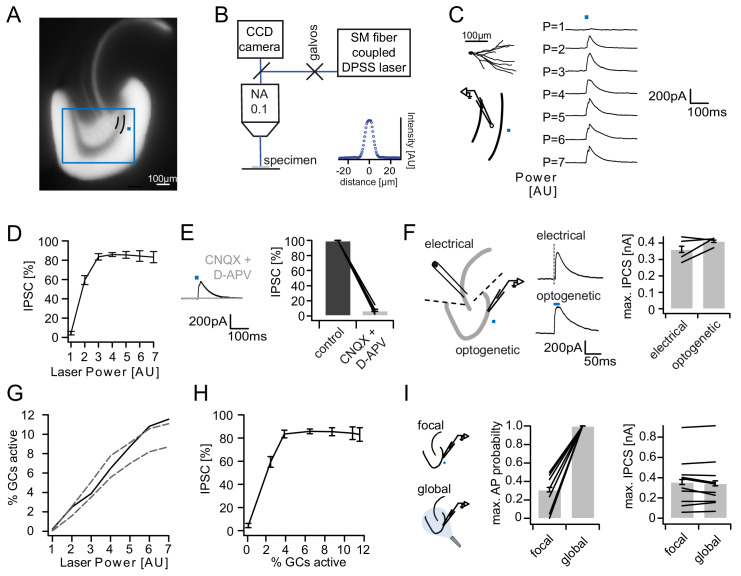
Recruitment of feedback inhibition assessed optogenetically.(A) EYFP fluorescence in dentate GCs of Prox1/ChR2(H134R)-EYFP transgenic mice. The field of view for rapid focal optogenetic stimulation is indicated by a blue square. A typical stimulation site approx. 40 µm from the GC layer (two short black lines) is indicated by a blue dot. (B) Schematic of the microscope setup used to achieve spatially controlled illumination. The inset shows the intensity profile of the laser spot. (C) Top left, reconstruction of an Alexa594 filled GC. Left, illustration of optical stimulation. Right, IPSCs following 20 ms light pulses at increasing laser power (p=1 to 7 AU). Each trace represents an average of three trials. (D) Summary of IPSC amplitudes from cells in the superior blade (n = 7 cells). IPSC amplitudes were normalized to the maximum amplitude within each cell. (E) Optogenetically elicited IPSCs are abolished by glutamatergic blockers (40 µM CNQX + 50 µM D-APV, n = 9). (F) Left, Schematic of focal optical and electrical stimulation. Dashed lines indicate cuts to sever CA3 backprojections. Middle, Example traces for IPSCs following electrical or focal optogenetic stimulation. Right, maximal IPSC amplitude for the two stimulation paradigms (361 ± 37 vs. 410 ± 13 pA for electrical and optogenetic stimulation respectively, paired t-test, p=0.28, n = 4) (G) The optogenetically activated GC fraction responsible for recruiting the IPSC at the respective laser powers was estimated from systematic cell attached recordings (see Figure 2—figure supplement 1 for details). The best estimate (black) incorporates measurements of the 3D light intensity profile in the acute slice. Upper and lower bounds were estimated by assuming no firing probability decay with increasing slice depth (upper grey dashed line) or isometric firing probability decay (lower grey dashed line. (H) Data from (D) and (H, best estimate) plotted to show the recruitment of feedback inhibition. (I) Comparison of focal optogenetic stimulation to global (light fiber mediated) optogenetic stimulation. Left, Schematic illustration. Middle, Comparison of the AP probability of individual GCs at maximal stimulation power for focal and global stimulation assessed by cell attached recordings. Right, Comparison of the maximal IPSC amplitude under focal and global stimulation for individual GCs.